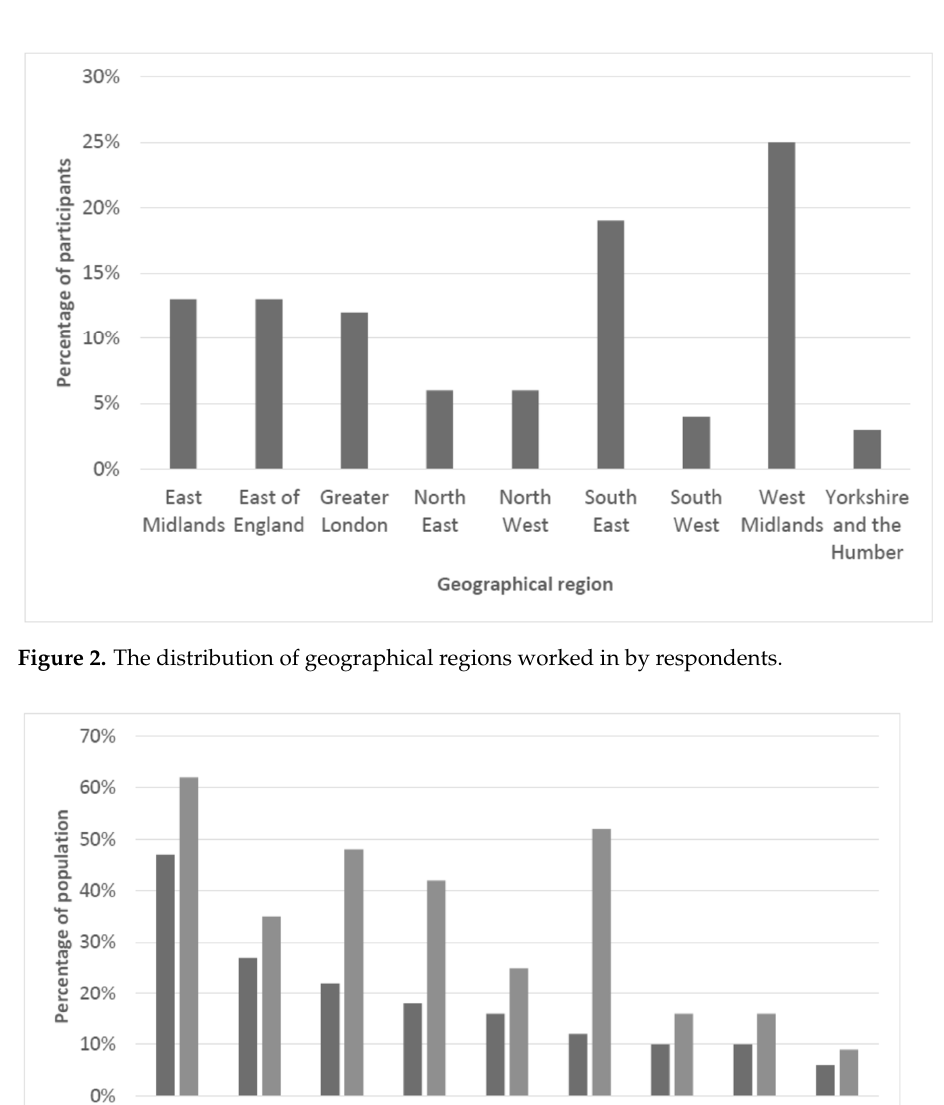
Figure 4. Distribution of experience in given types of the offsite construction method. (Direct expe- rience was stated as “You have been directly involved in a project where the following offsite con- struction methods were considered or used”). 3.8. Perceived Barriers to Offsite Construction The findings from the questionnaire survey indicated the inability to achieve econo- mies of scale and increased project costs were the two most selected barriers (both 35%), closely followed by increased capital cost (33%), the capacity of suppliers (32%) and end-